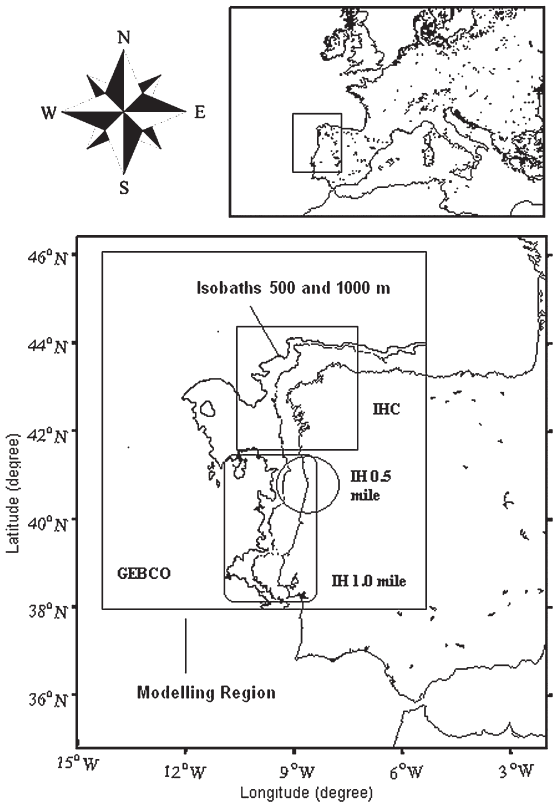
f ig . 1. – Study area (NW Iberian Peninsula) highlighting the model- ling region and the four sources of the ocean topography: GEBCO topography (whole modelling region), IHC cartography (rectangle), IH cartography with 0.5 miles resolution (circle) and IH cartography with 1 mile resolution (rounded